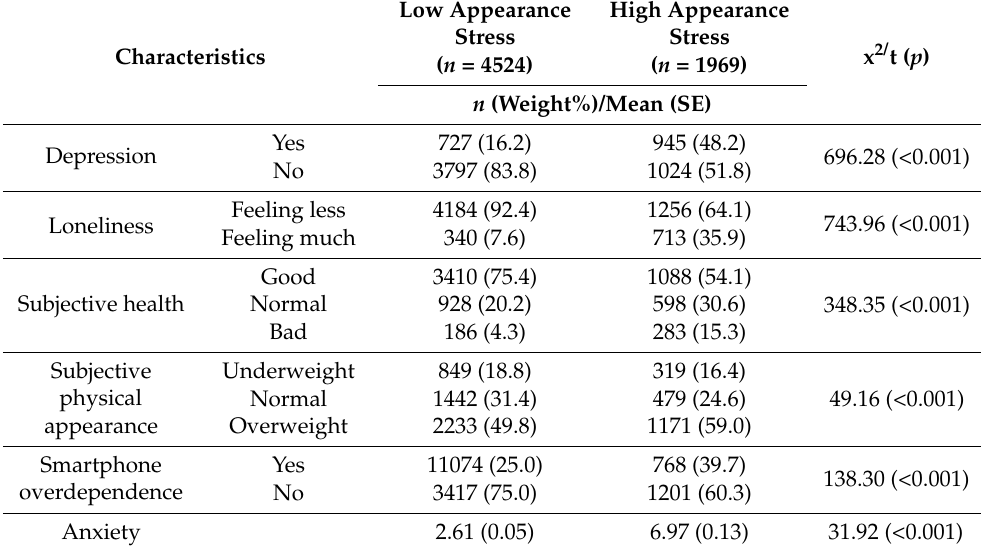
Table 4. Psychological factors ( n =